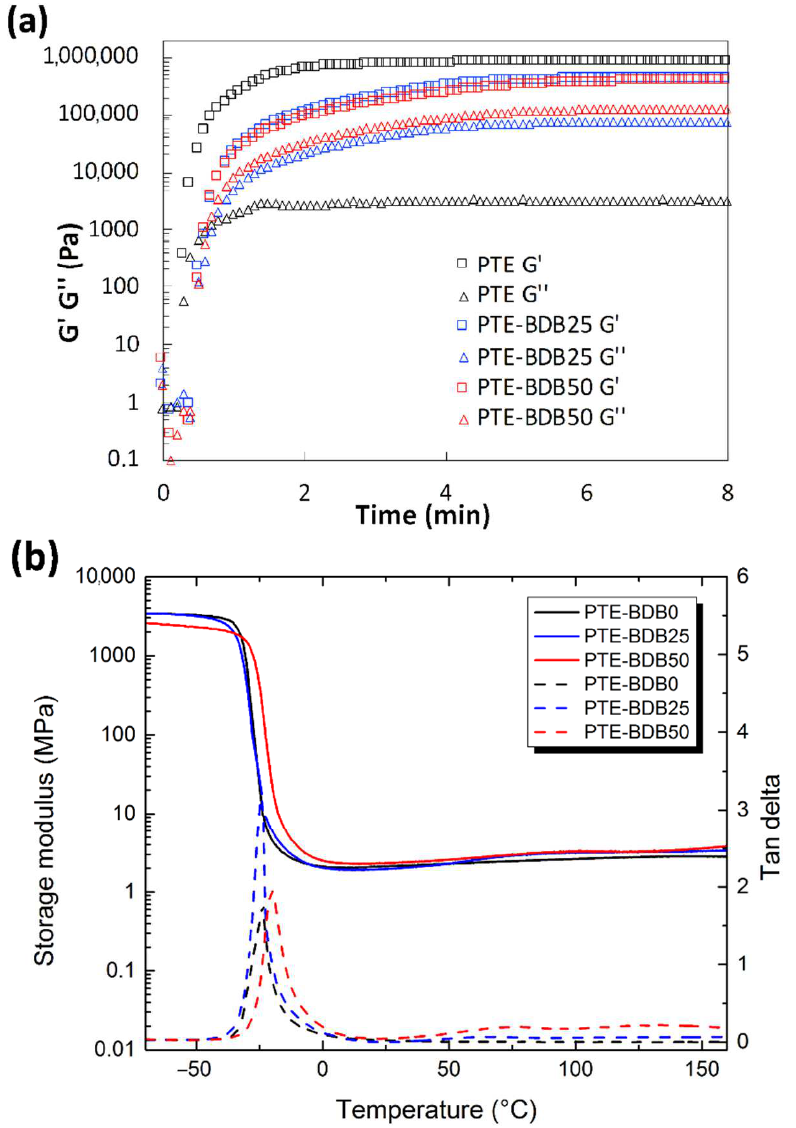
Figure 2. ( a ) Rheological studies of PTE-BDB0, PTE-BDB25, and PTE-BDB50 precursor mixtures during in-situ photopolymerization; ( b ) DMA curves of PTE-BDB series samples.